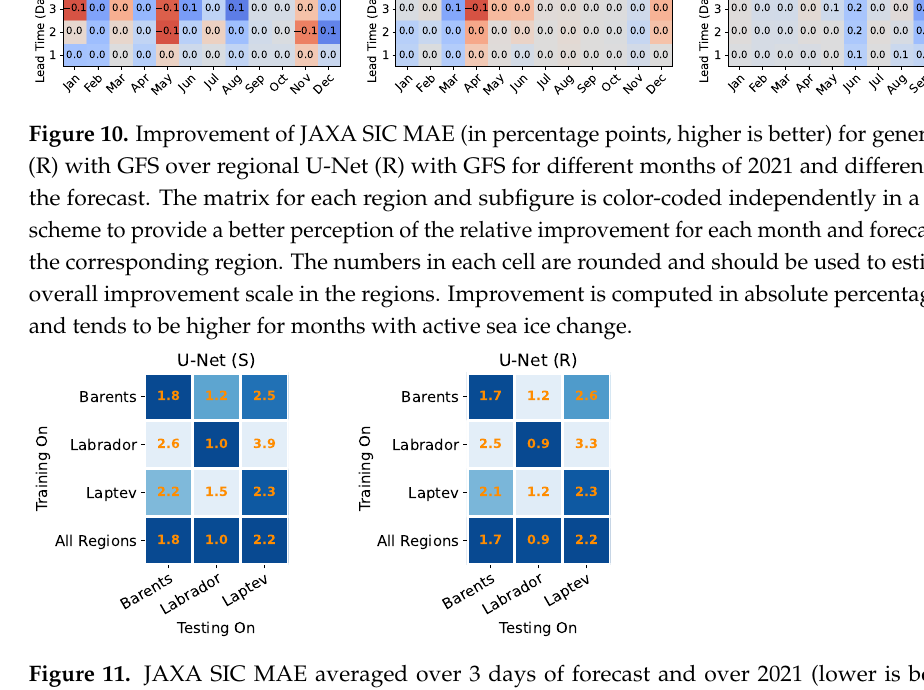
Figure 11. JAXA SIC MAE averaged over 3 days of forecast and over 2021 (lower is better) for different train-test region configurations. The models trained in any region are expected to perform best in this region, and the general model (trained in all three regions) is expected to perform well in all of them. Each column of both matrices is color-coded independently in a white-blue scheme so that lesser MAE values correspond to a darker shade. Independent coloring provides a better perception of the best training setting for each testing